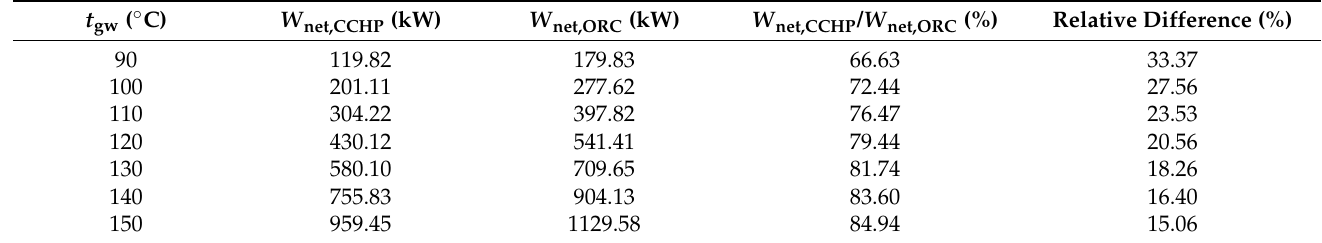
Table 8. Power generation comparison between CCHP and ORC system.